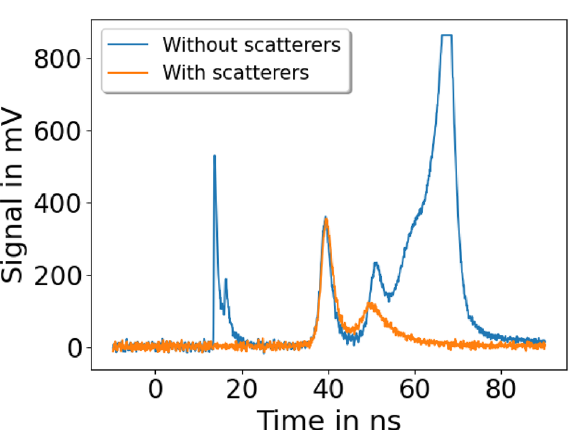
Figure 8. The time-of-flight beam monitoring system signal during high dose operation mode with and without 100 µ m lead scatter foil at Sc2 position. Without scatter foil, the laser light induced zero signal at 15 ns used for flight time reference and transported ion types other than protons are visible. The other ion ∼ types are producing the strong signal (clipped due to limited dynamic range) after the two proton peaks at 40 ns and 50 ns . The second proton peak is temporally overlapping with the other ion ∼ ∼